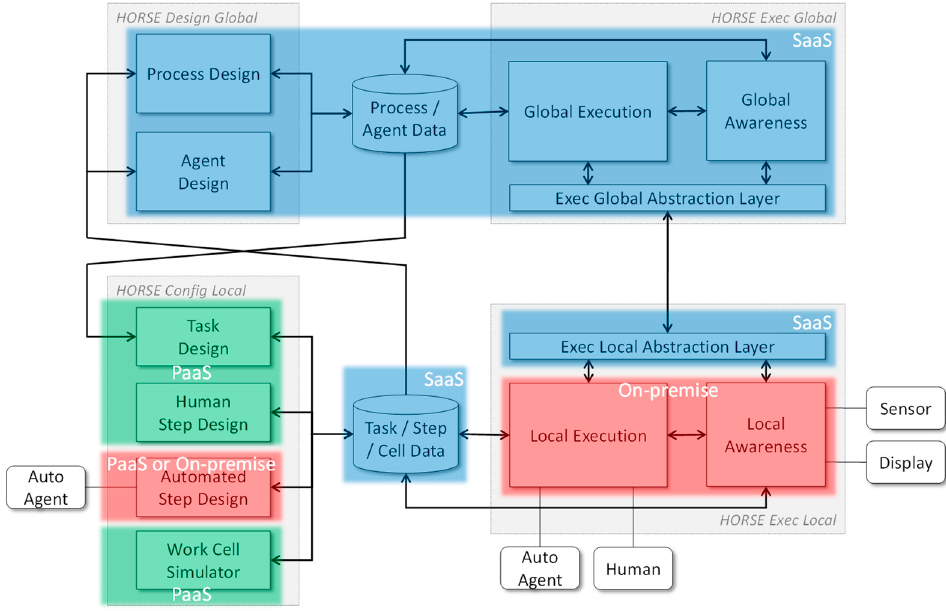
Figure 10. Overview of cloud support for the HORSE System.